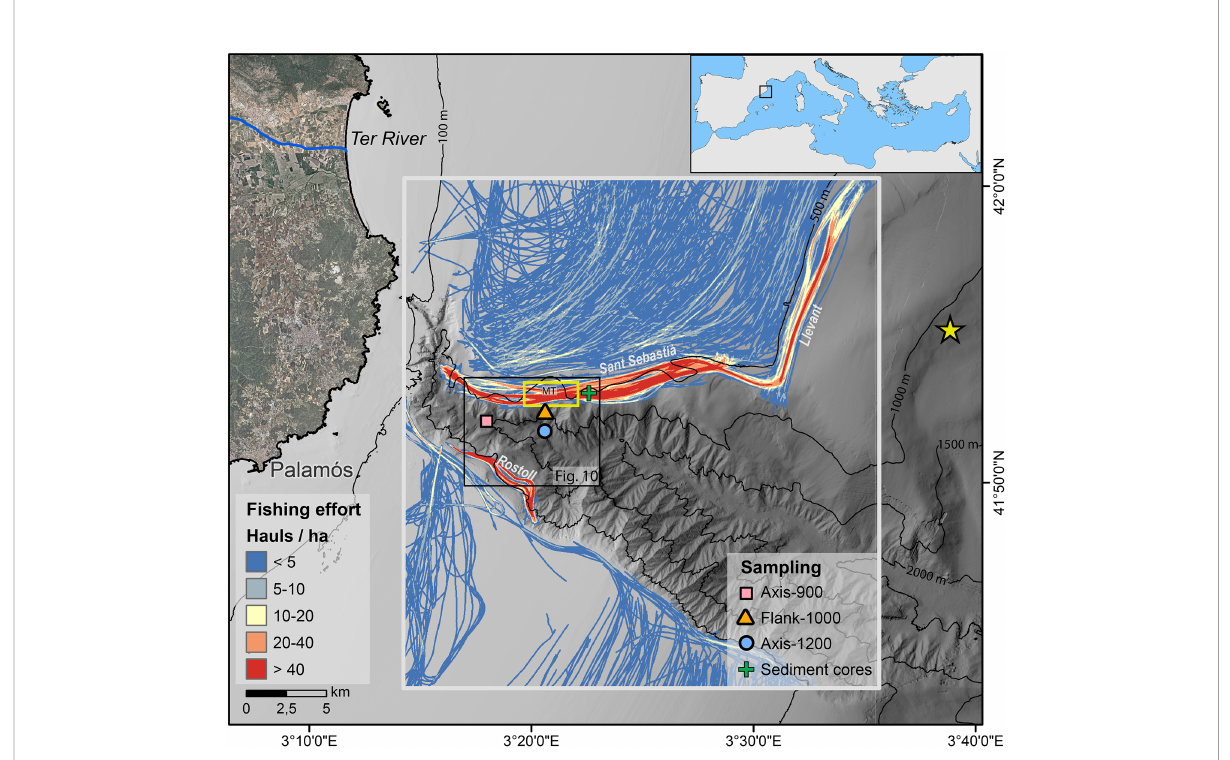
FIGURE 1 Bathymetric map of Palamo ́ s Canyon, with the location of Axis-900 (pink square) mooring at the canyon axis, Flank-1000 mooring (orange triangle) deployed in the Montgr ı ́ tributary gully (MT) and Axis-1200 mooring (blue circle) deployed in the con fl uence between MT and the canyon axis. The yellow rectangle above the Flank-1000 mooring delimits the section of the fi shing ground where daily hauls were extracted for Figure 2. Composition of the sediment trap (Axis-1200) was compared with sur fi cial composition of the sediment core collected in the trawled fl ank (green cross). Fishing effort is given as cumulative number of hauls per hectare obtained from AIS data from February to December 2017, identifying the main fi shing grounds (Sant Sebastià, Rostoll, Llevant). The location of the Cap Begur buoy is given by a yellow